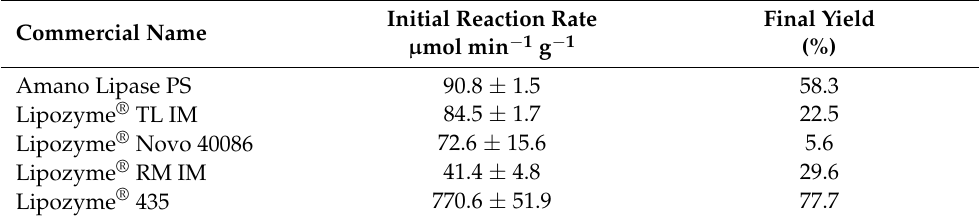
Table 2. Initialsynthesisreactionrateofascorbylpalmitateofthecommercialimmobilizedlipasesevaluated.